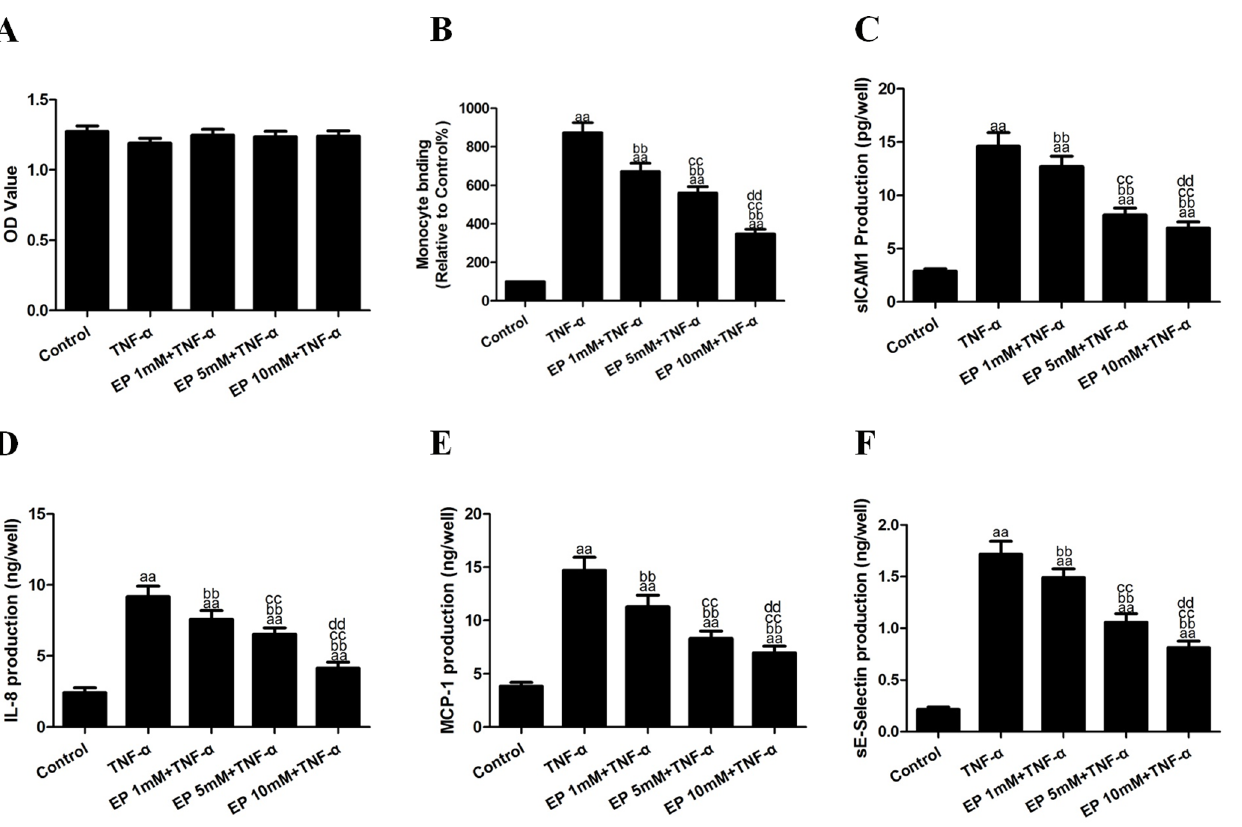
Figure 2. Effects of EP on TNF- a -induced cell viability, monocyte adhesion and inflammatory cytokines in cell culture supernatants. A. Cell viability is expressed as an OD value. B. The adhesion of U937 monocytes to HUVECs. C. The levels of sICAM1 production in cell culture supernatants. D. The levels of IL-8 production in cell culture supernatants. E. The levels of MCP-1 production in cell culture supernatants. F. The levels of sE-selectin production in cell culture supernatants. The results are expressed as the means ¡ SD, n 5 6. aa P , 0.01, compared with the control group; bb P , 0.01, compared with the TNF- a group; cc P , 0.01, compared with the 1 mM EP + TNF- a group; dd P , 0.01, compared with the 5 mM EP + TNF- a group. EP, ethyl pyruvate; OD, optical density.